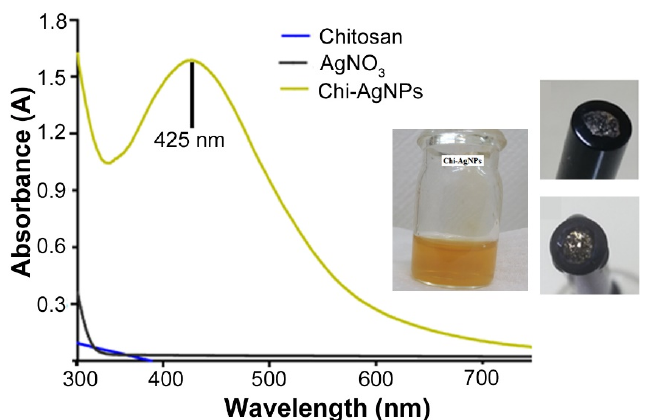
Figure 1. UV-vis spectral analysis of the synthesized Chi-AgNP, chitosan and AgNO 3 . The inset shows an image of the stabilized NPs and the modified electrodes. Sensing electrodes are formed by depositing 8 µ l of the solution (inset) on glassy carbon. On drying, the particles are firmly adhered and do not detach even after several hours of incubation in PBS